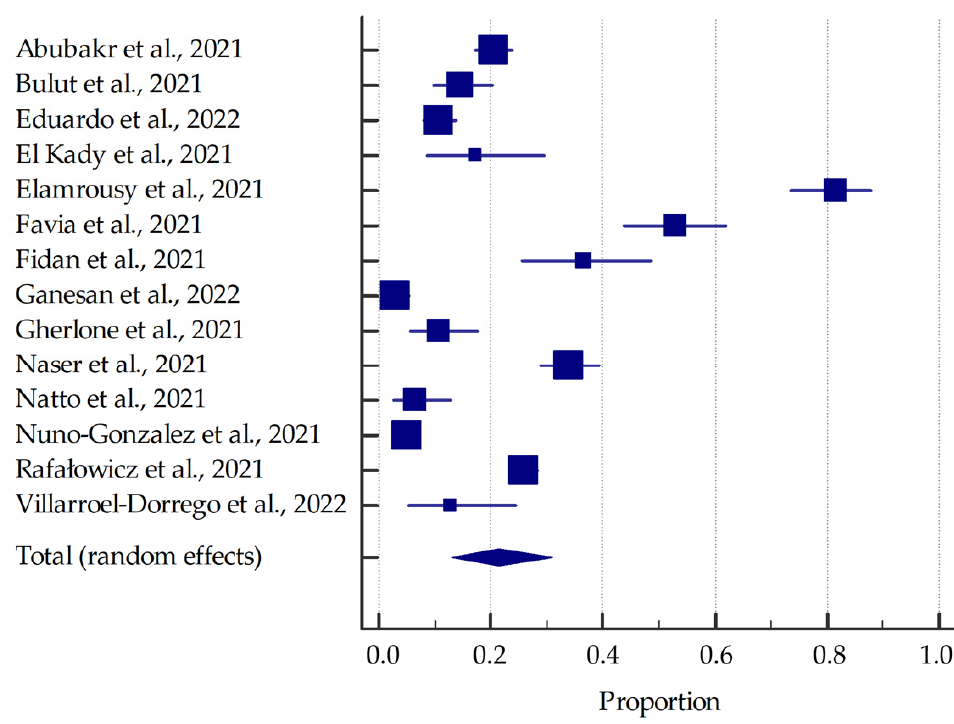
Figure 5. Forest plot presenting the summarized prevalence of ulcerations among SARS-CoV-2 positive